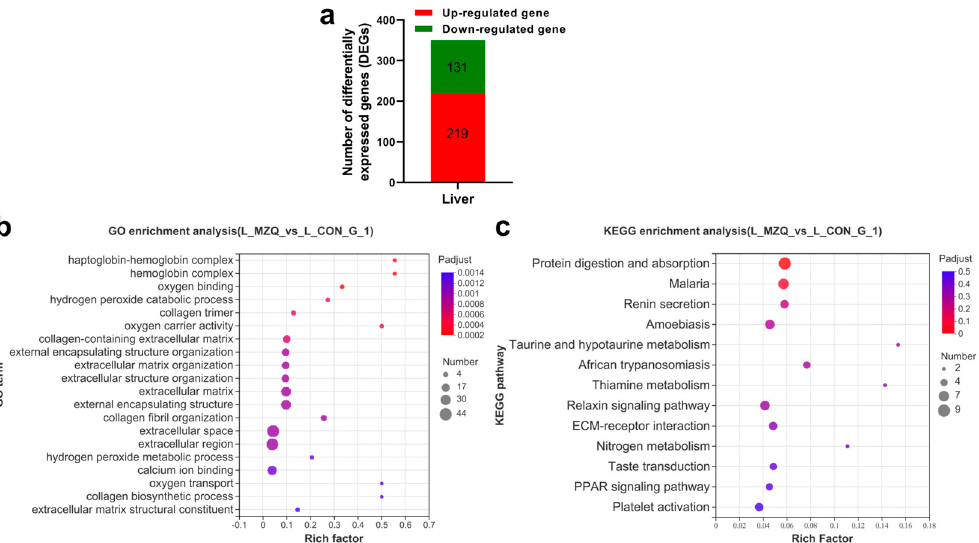
Figure 5. Transcriptomic analysis of the liver. ( a ) DEGs between the ZQ-1 g and control. ( b ) Bubble plot of the enriched GO terms of the liver. ( c ) Bubble plot of the enriched KEGG pathways of the liver. Table 4. DEGs in the liver of the ZQ-1 g pigs in comparison to the control pigs.